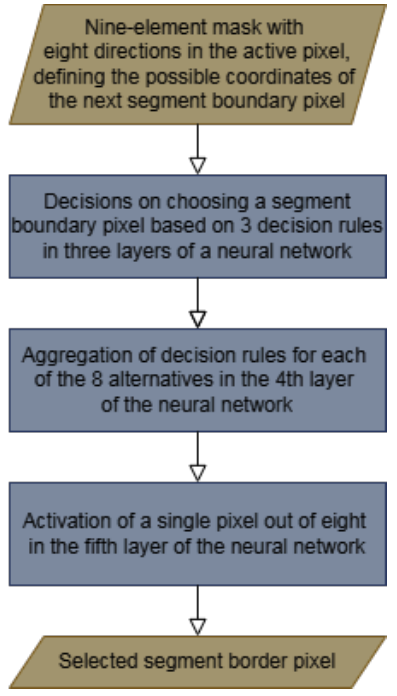
Figure 21. Sequences of image transformation by neural